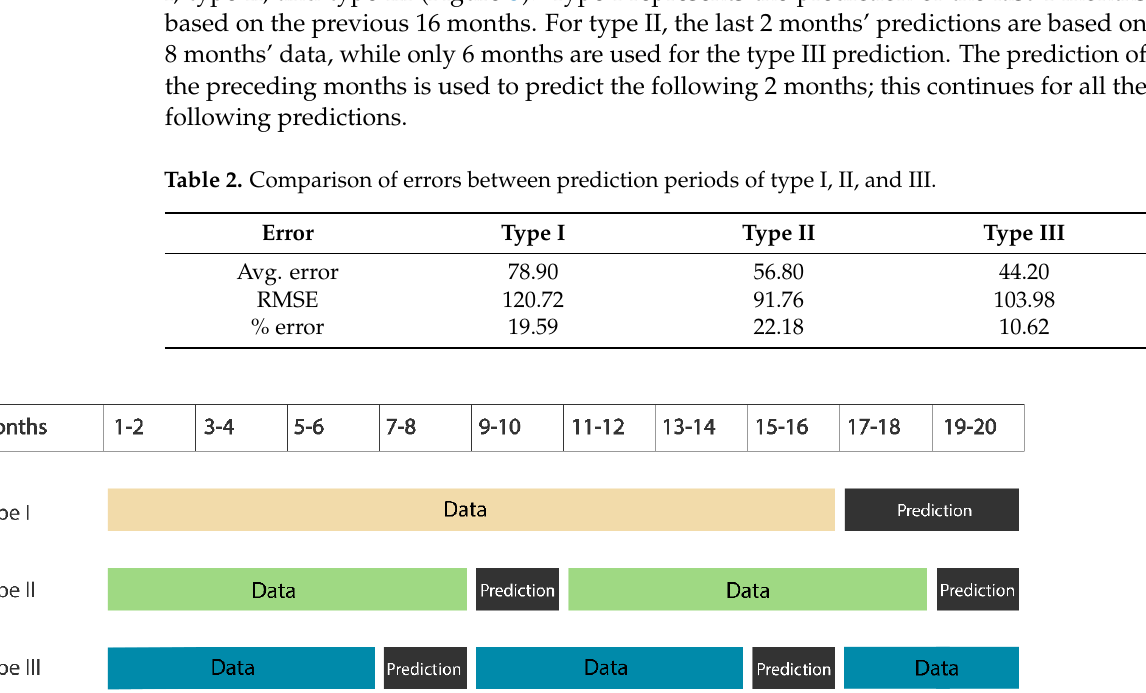
Figure 3. Illustration of different types of prediction periods for demand forecasting. Type I: GA applied to an entire period; Type II: GA applied to the first eight months for forecasting; Type III: GA applied to the first six months for forecasting.